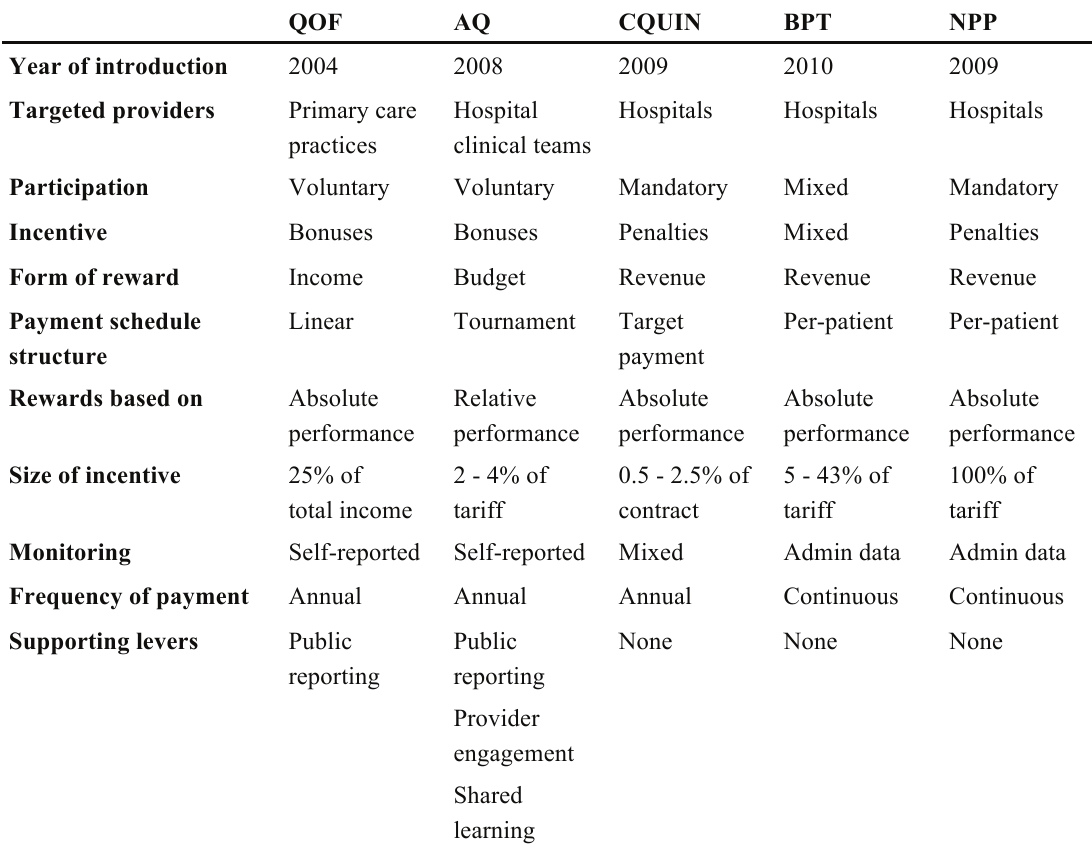
Table 1: An overview of pay-for-performance policies introduced in England QOF AQ CQUIN BPT